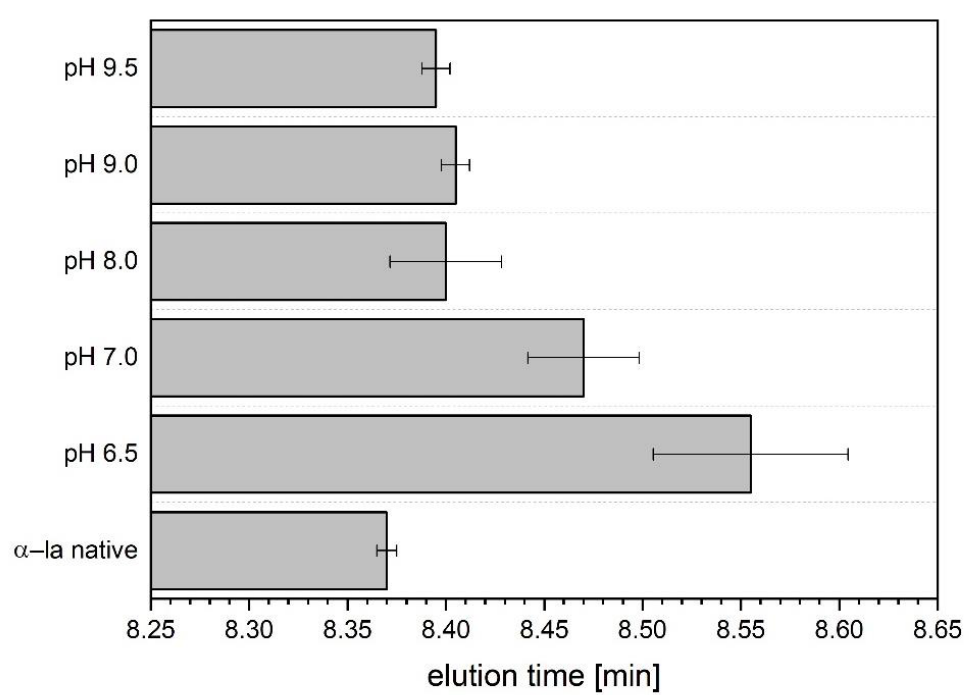
Figure 3. Elution times in RP-HPLC analysis of native reference and refolded α -la samples at different pH values. Data are given as mean ± SD, n = 2. All refolded batches were significantly different from native α -la ( p < 0.05).